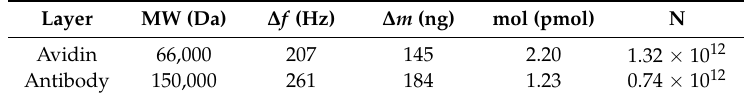
Table 1. Frequency shift, mass, and number of molecules in each step of surface